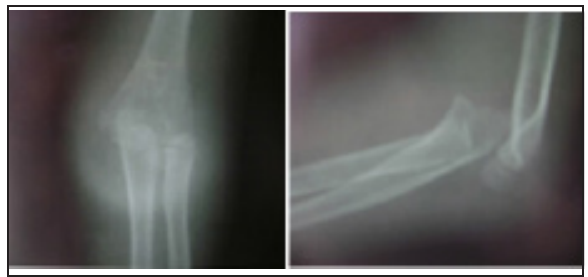
Figure 2. Radiographs, four months after open reduc- tion, show congruous elbow joint.